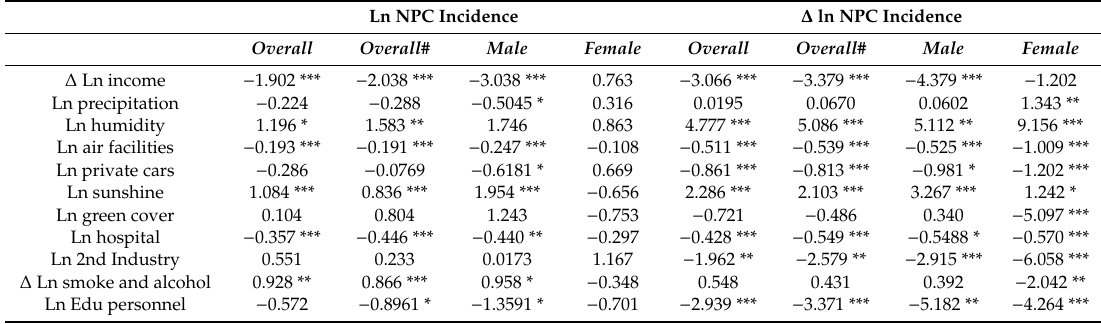
Table A1. Association between air pollution and NPC incidence and NPC incidence growth rate (Estimation result of control